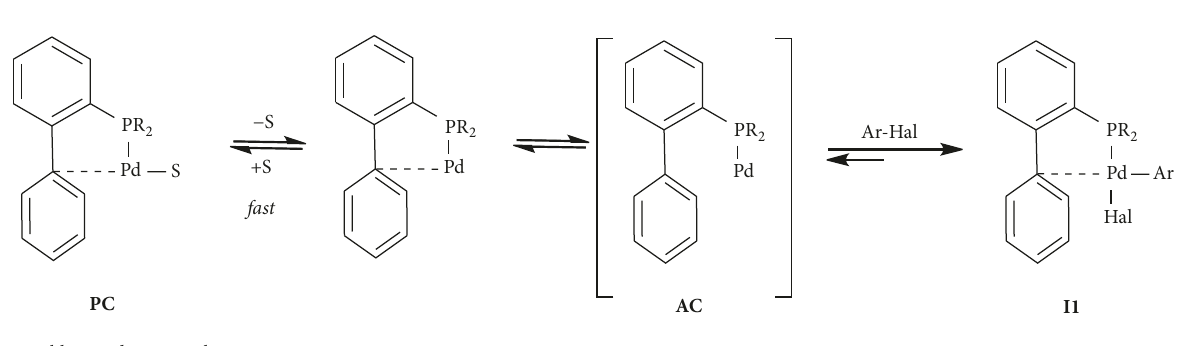
Figure 1: Selected chiral ligands used in SM